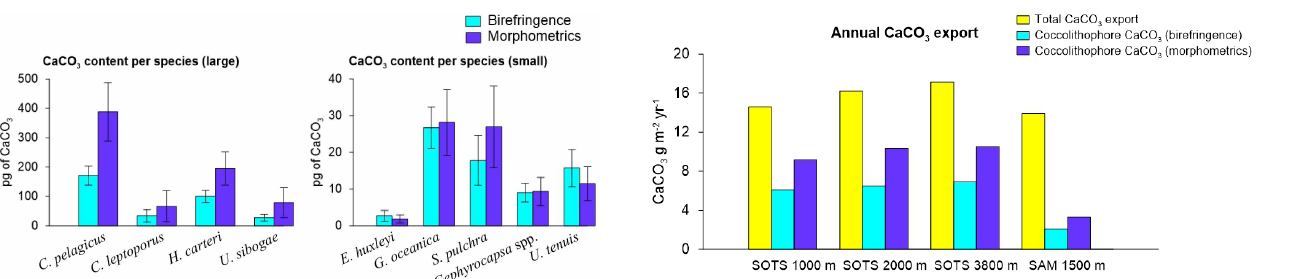
Figure 4. Average and standard deviation of the coccolith mass es- timates of the most important coccolithophore species captured by the SOTS and SAM sediment traps using birefringence (C-Calcita) and morphometric approaches. For E. huxleyi , the morphometrics- based coccolith mass estimate was calculated by applying a mean shape factor constant ( k s ) value estimated from the range of all the morphotypes found at the SAZ (i.e. k s = 0 . 0275, Table 1).